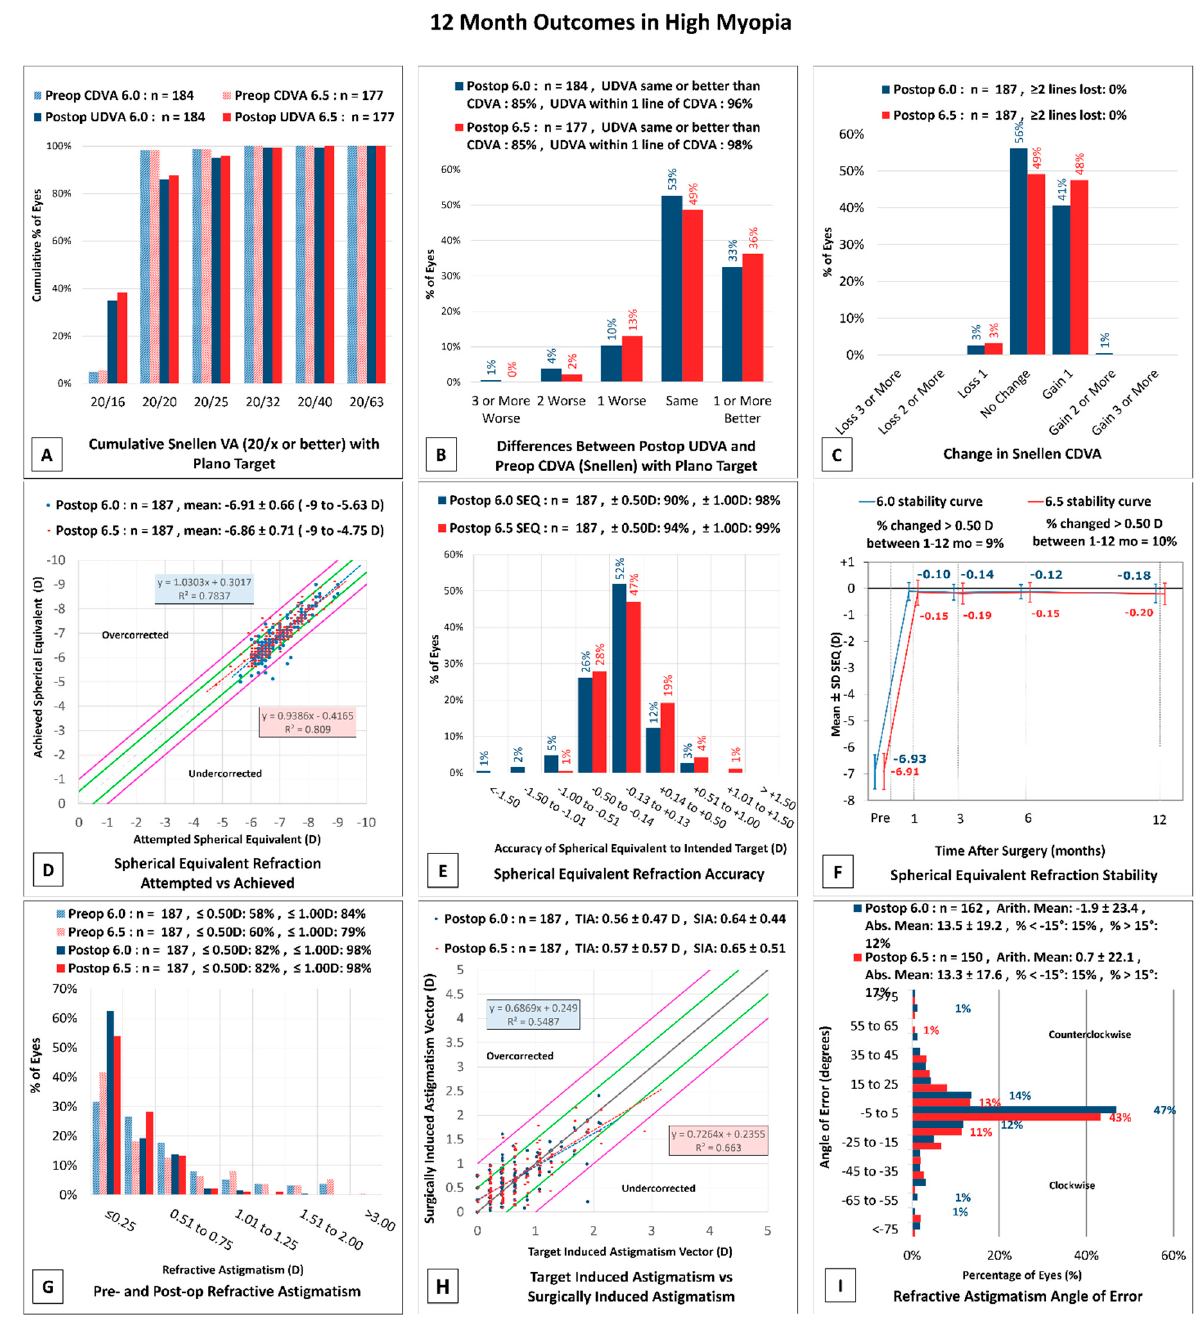
Figure A3. Standard reporting of visual and refractive outcomes for eyes at twelve months postoperatively between 6.0 and 6.5 mm in High Myopia. ( A ) Cumulative preoperative CDVA and postoperative UDVA; ( B ) difference between preoperative CDVA and postoperative UDVA; ( C ) change in Snellen CDVA; ( D ) Attempted vs. achieved MRSE; ( E ) accuracy of MRSE; ( F ) MRSE stability at one, three, six, and 12 months; ( G ) comparison of preoperative and postoperative manifest cylinder; ( H ) target-induced vs. surgically-induced astigmatism; ( I ) angle of error.